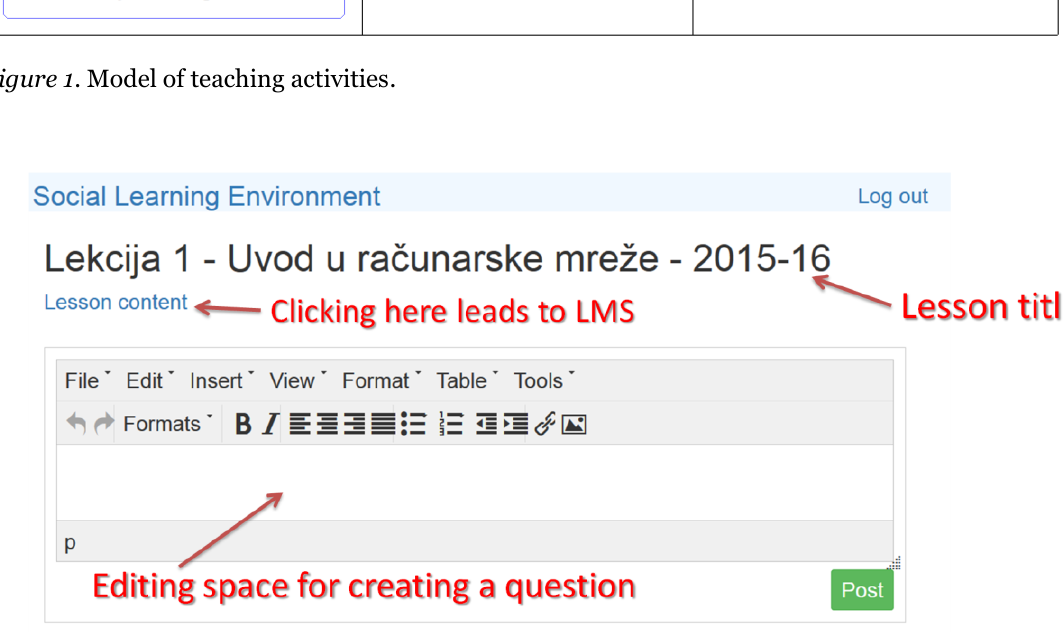
Figure 2. Initial interactive learning space in